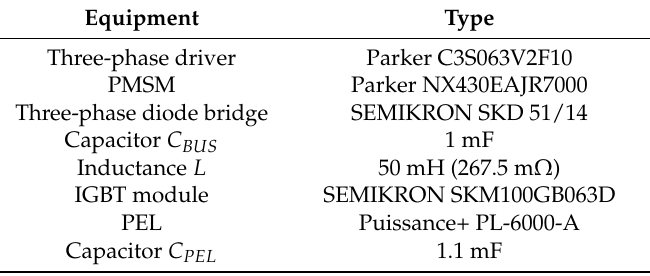
Figure 1. ( a ) Test bench electric scheme; ( b ) Image of the test bench; ( c ) Power coefficient function. Table 1. Detailed information of equipment. PMSM: permanent magnet synchronous machine; PEL: programmable electronic load. Equipment